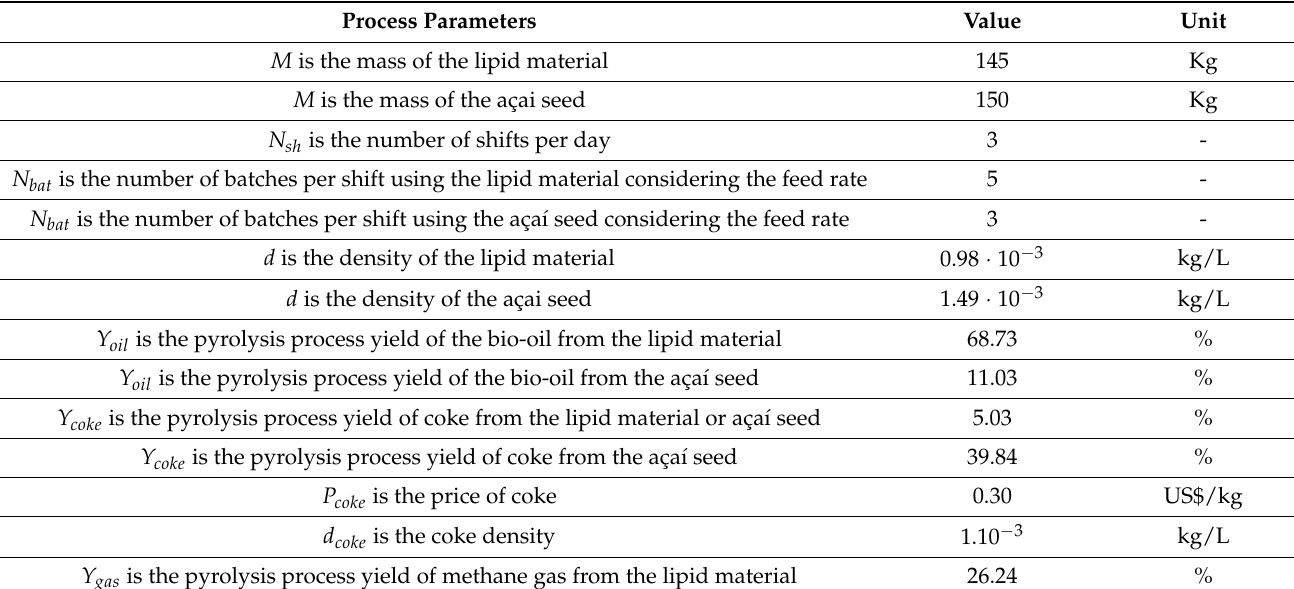
Table 1. Process data used to compute the economic